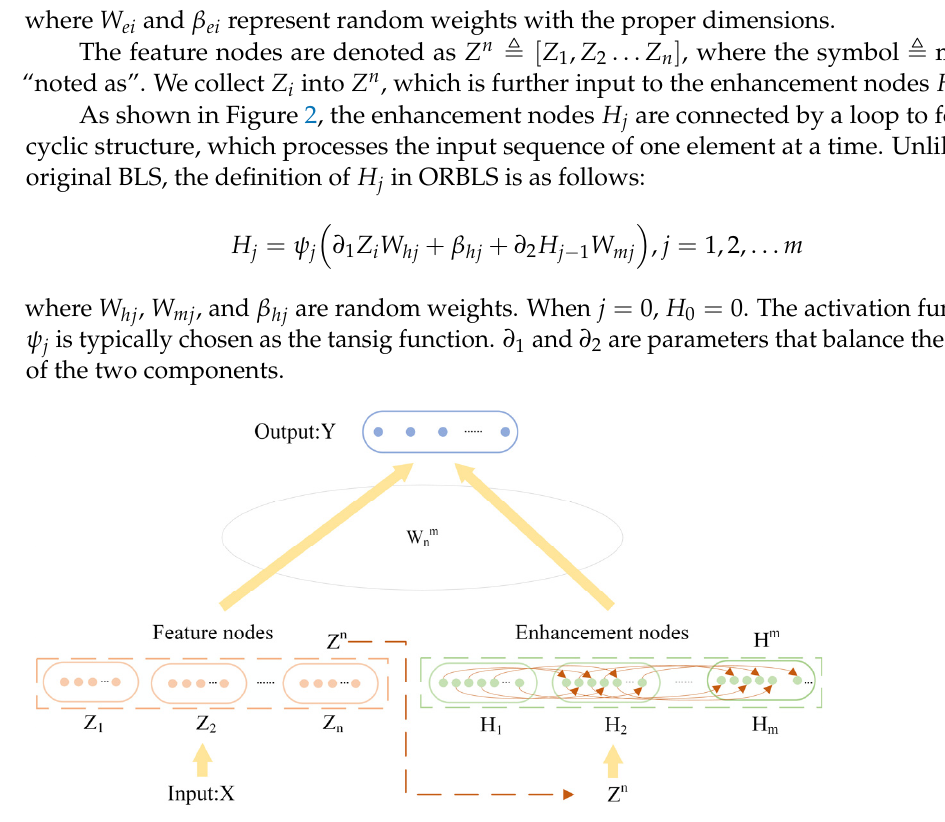
Figure 2. Structure of the